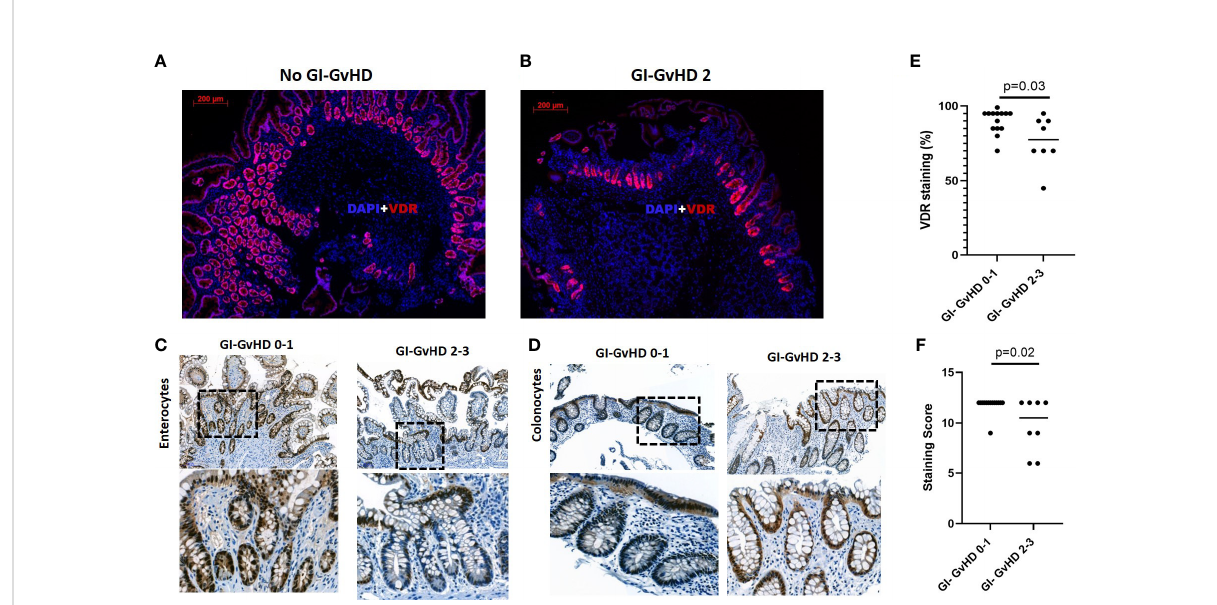
FIGURE 2 Immuno fl uorescence and immunohistochemistry of VDR protein in the gastro-intestinal tract of patients after allogeneic stem cell transplantation. (A) VDR protein expression (red) in the absence of acute GI-GvHD. (B) VDR protein expression in high Lerner (Grade 2) GI- GvHD. Nuclei were counterstained with DAPI (blue). Magni fi cation: 5X objective lens. Scale bar: 200 µm. (C) VDR+ enterocytes in the small intestine of low and high Lerner GvHD patients. (D) VDR+ colonocytes in the large intestine of low and high Lerner GvHD patients in the areas with vital mucosa. Lower panel in C & D represents magni fi ed image of upper panel from selected area. Upper panel, C&D, scale bar, 100 µm. (E) Semi-quantitative scoring of VDR+ cells in the gut biopsies. (F) Semi-quantitative scoring of VDR intensity score in the gut biopsies. Dot plots are used to represent semi quantitative score. Line represents median of the values. p value, Mann-Whitney U